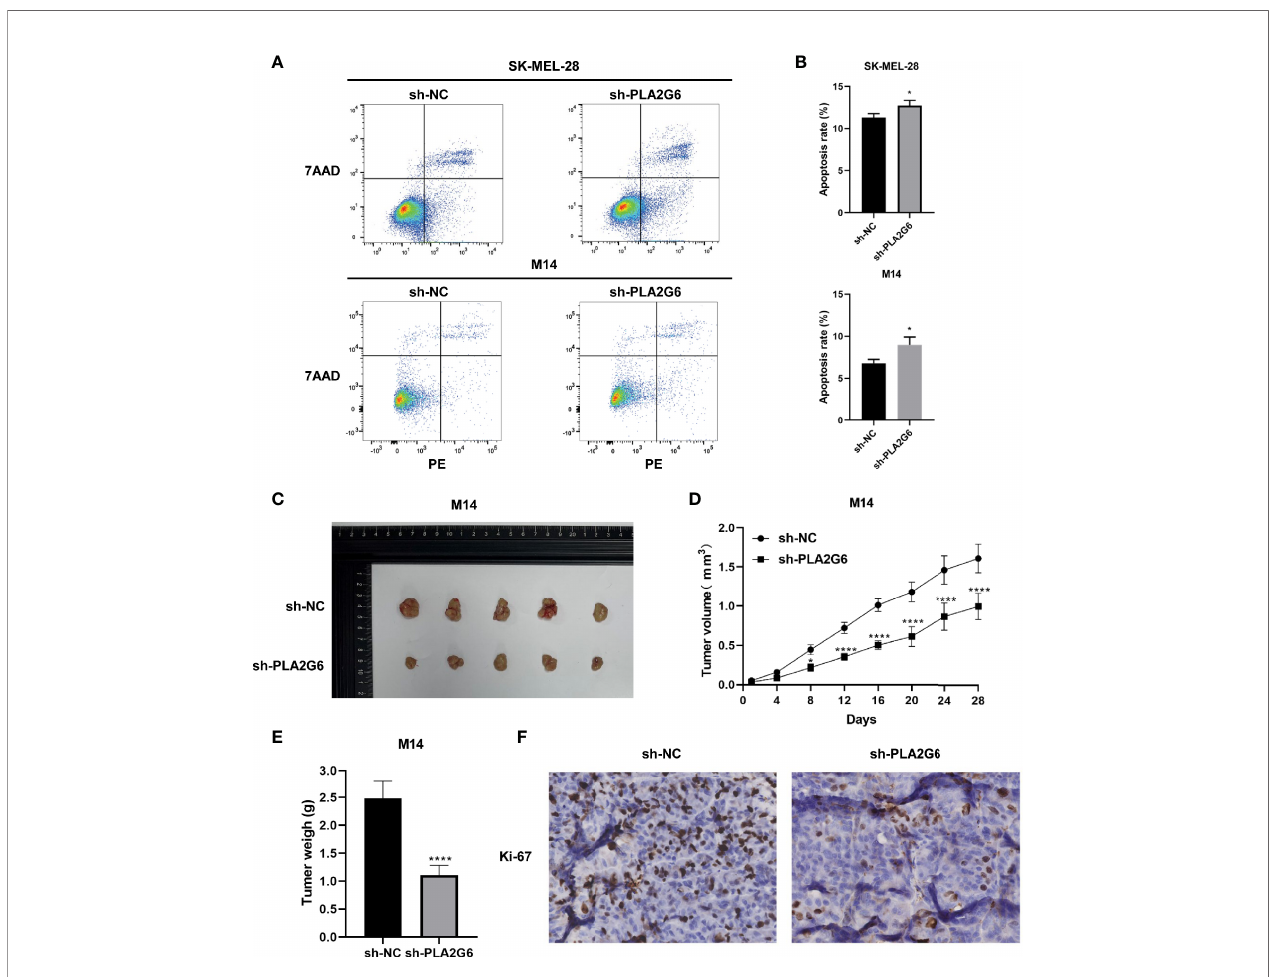
FIGURE 5 | PLA2G6 knockdown promotes apoptosis in vitro and suppressed xenograft tumor growth in nude mice. (A, B) Cell apoptosis of SK-MEL-28 and M14 cells detected by fl ow cytometry. (C) Representative images of xenograft tumor mass sacri fi ced at 4 weeks. (D) Tumor volume was assessed every 4 days. (E) Average tumor weight was determined after the mice were sacri fi ced at the end of treatment. (F) Proliferation marker Ki-67 was detected by immunohistochemical staining. * P < 0.05, **** P <